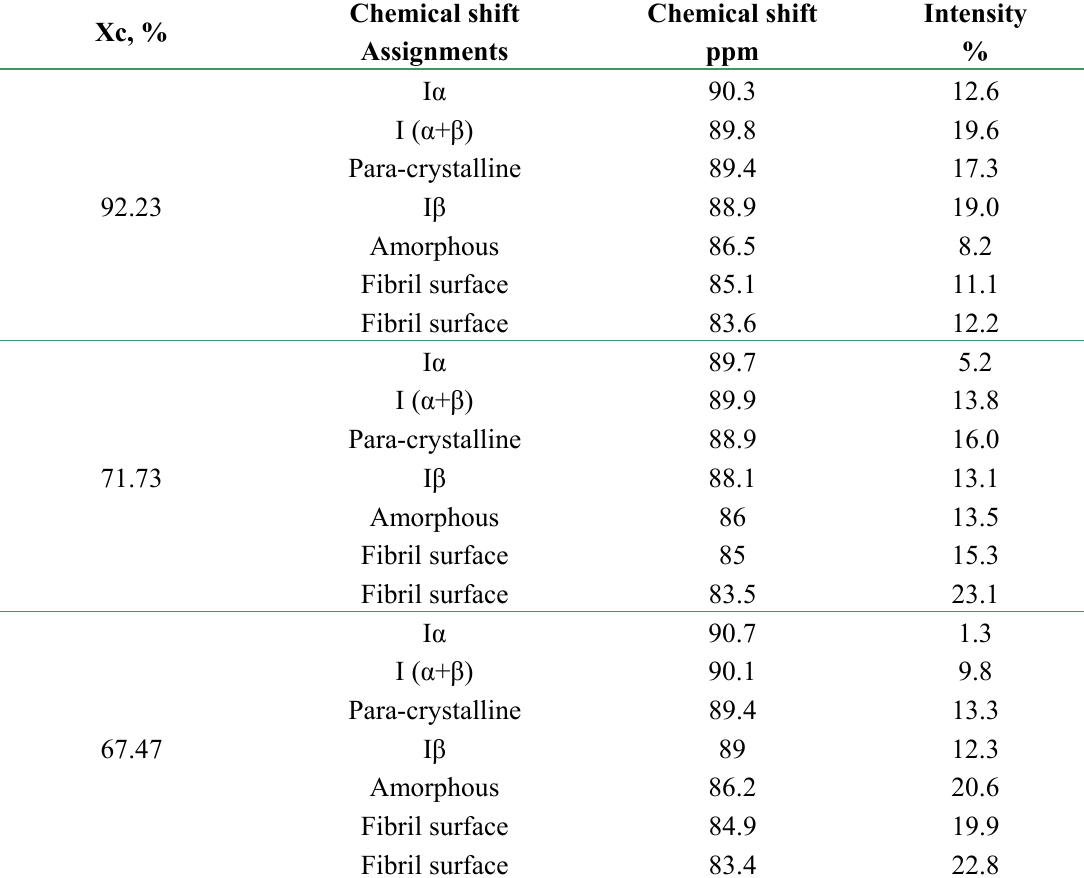
Table 2. Assignments and Intensity of Non-linear Least-squares fitting of the C the CP/MAS 13 C-NMR Spectra from MCC with different degrees of